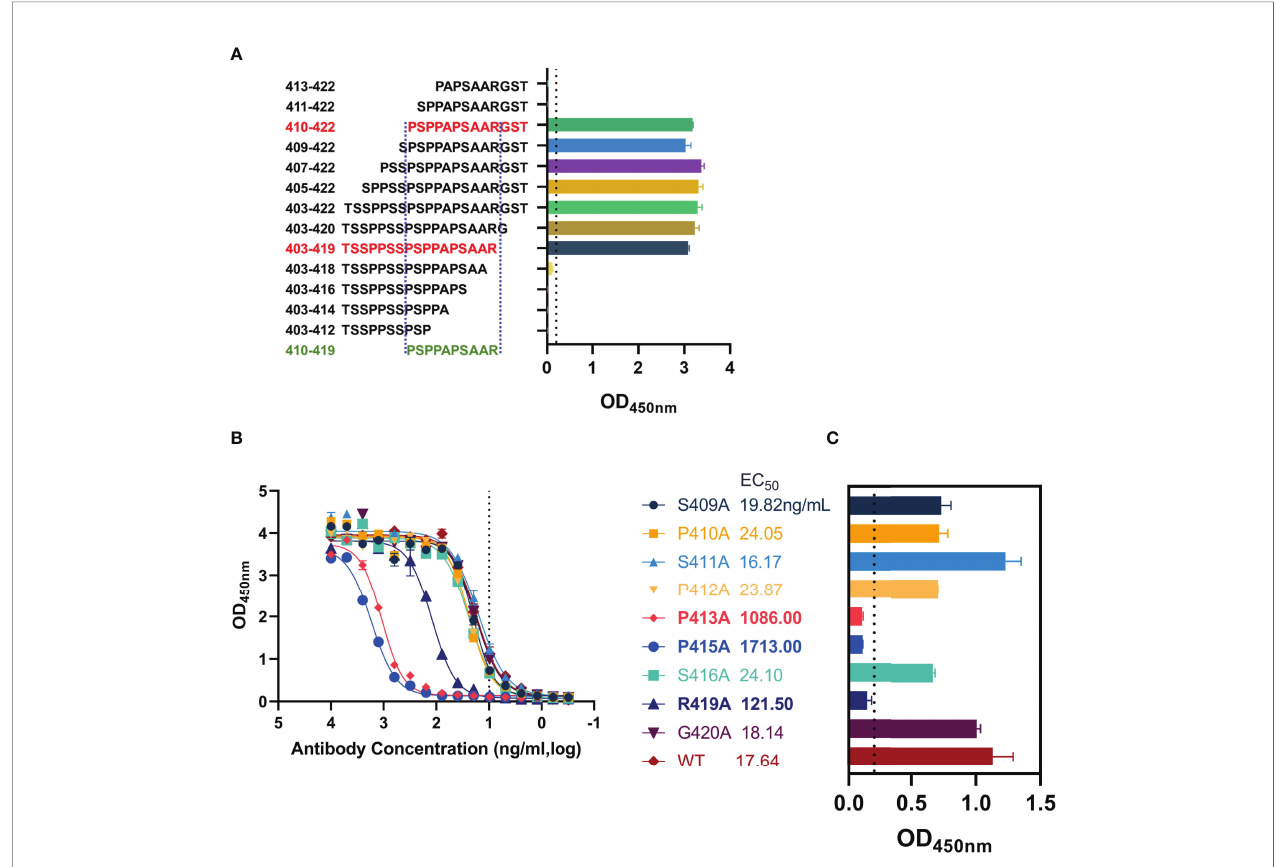
FIGURE 5 | Key residues validation of AMMO5. (A) Biotinylated truncated peptides covering aa 403 – 422 were used to identify the core epitope recognized by AMMO5. (B, C) Alanine scanning library spanning aa 410 – 419 was used for determining the key residues of AMMO5. (B) AMMO5 was serially diluted and evaluated using ELISA. (C) The OD values were displayed when the antibody concentration was 1 m